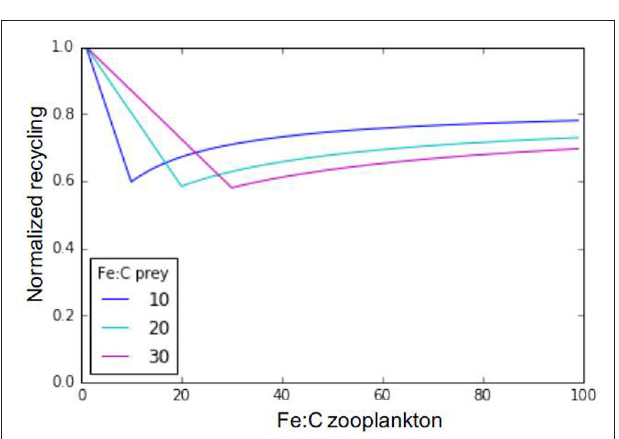
FIGURE 7 | Relationship between zooplankton iron recycling, normalized to its maximum value, and zooplankton iron stoichiometry. The different lines represent different prey